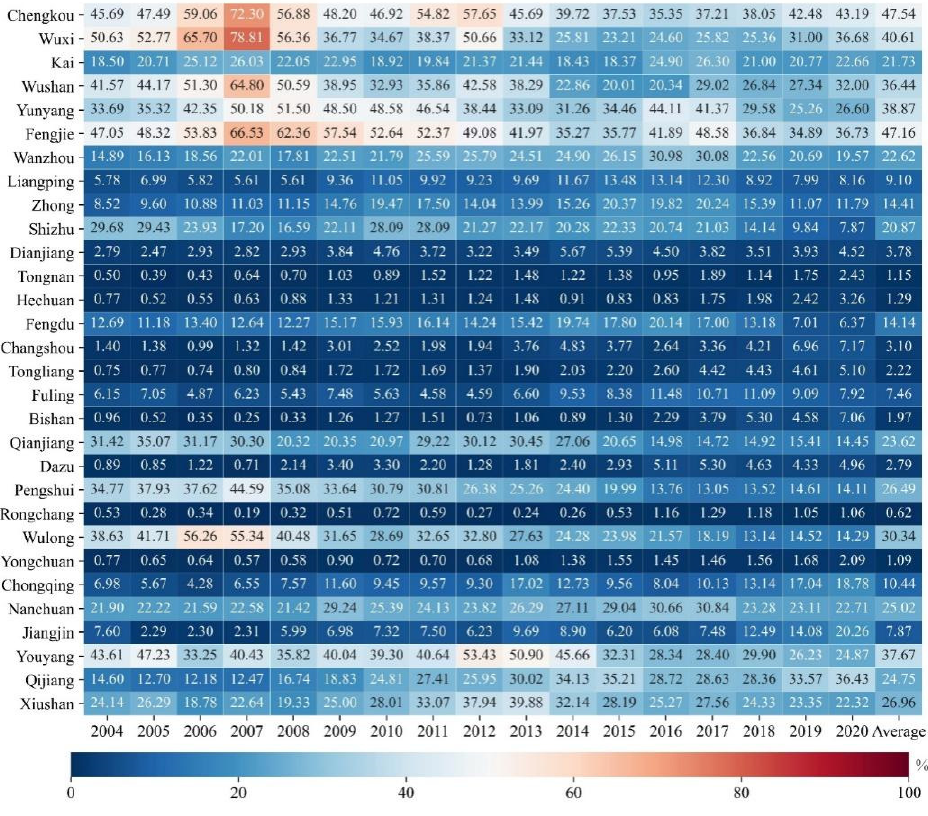
Figure 6. Cropland abandonment rates of counties in Chongqing from 2001 to 2020.